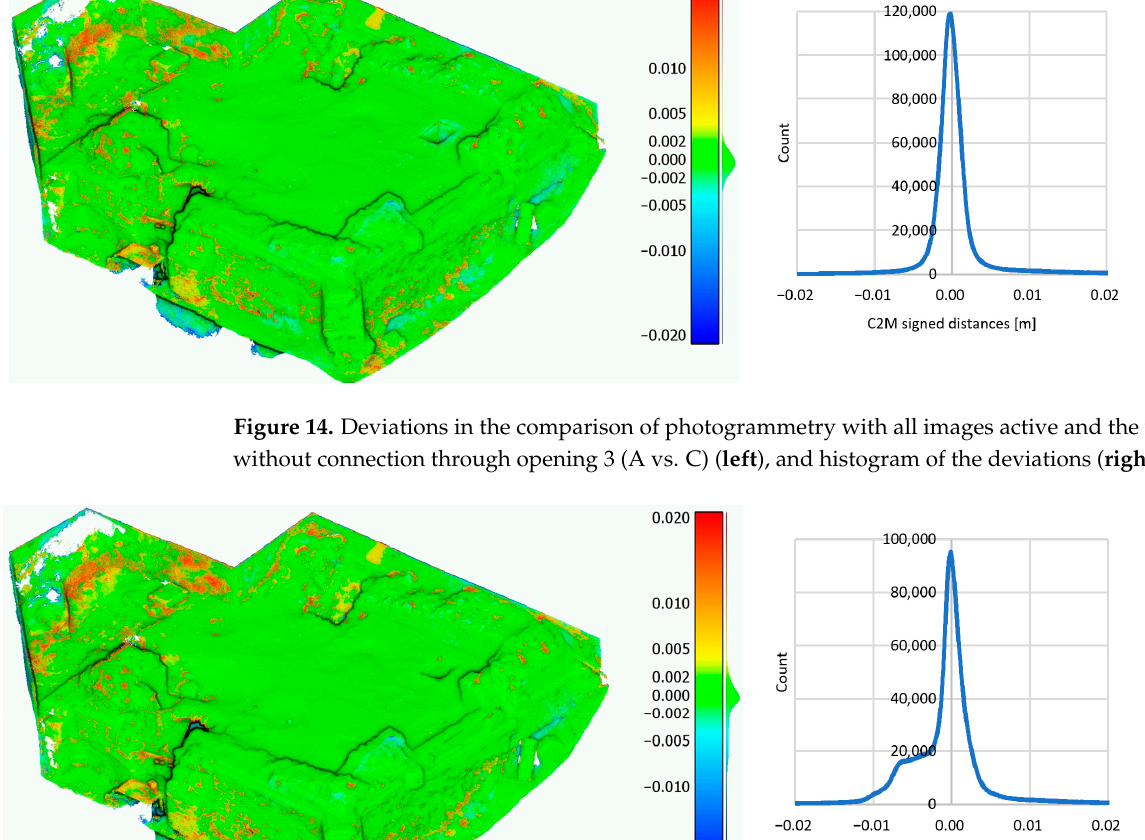
The differences in the graphs visible in Figures 13–15 were caused by the different